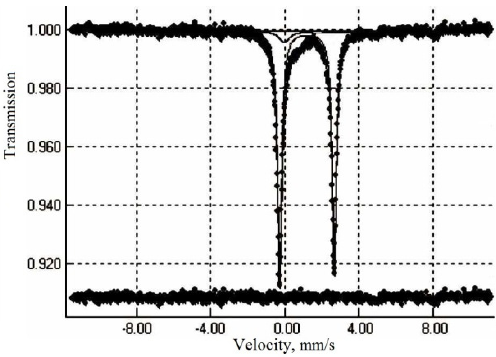
Figure 3. Mössbauer spectrum of the synthesized LiFePO 4 /C.